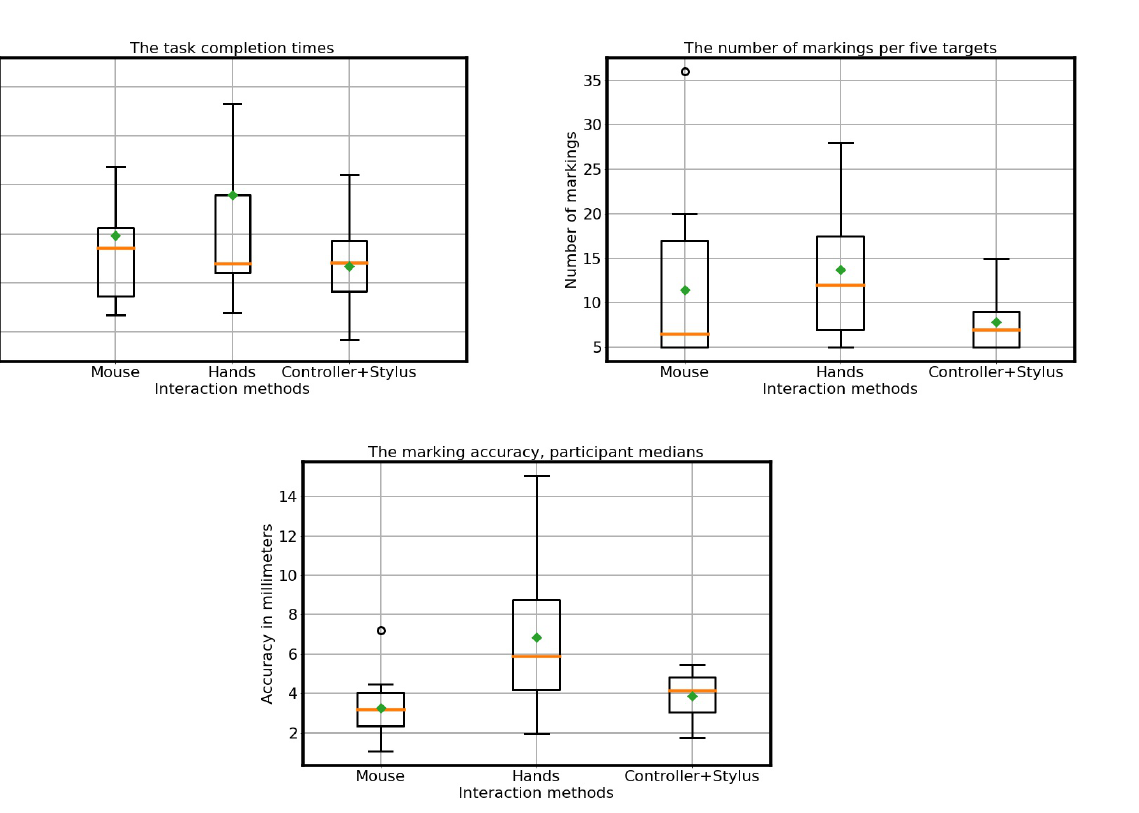
Figure 4. Box plot visualizations of the objective measurements. The trial completion times for different conditions ( top left ): The median values for each participant are rather similar between the methods. There were two outlier values (by the same participant, for mouse and hands conditions) that were removed from the visualization. The number of markings per five targets ( top right ): There were some differences between the interaction methods (the median value for hands was higher than for the other methods), but no significant differences. The marking accuracy ( bottom ): There was a significant difference between mouse and hands conditions, but no other significant